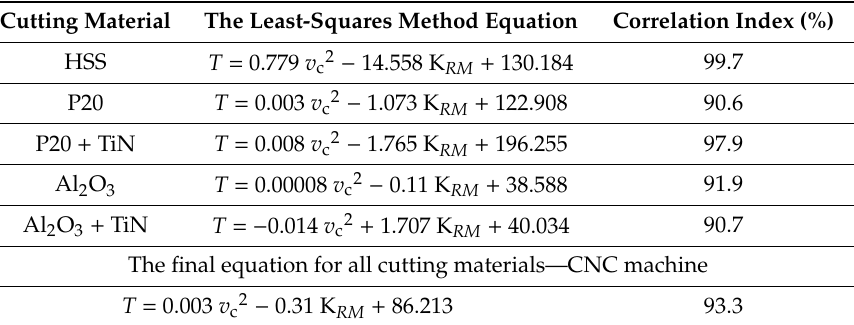
Table 12. T-v c equations for CNC machine.